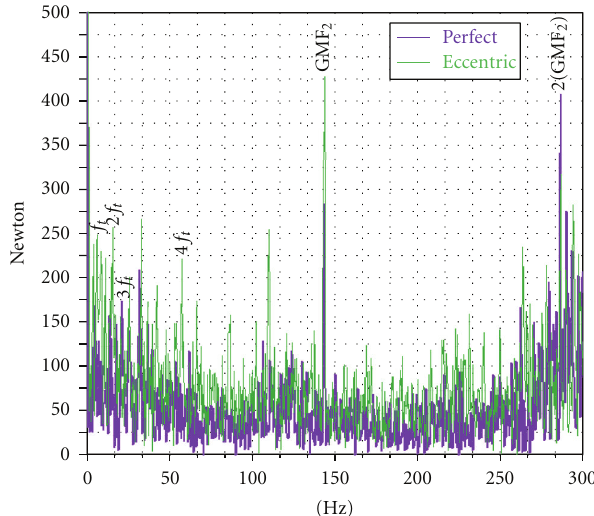
Figure 11: Frequency domain components of force magnitude on Stage 2 with an eccentric gear tooth, initial conditions: input shaft, − 1.49 N-m, intermediate shaft, − 5.27 N-m; output shaft, 12.5 rad/s